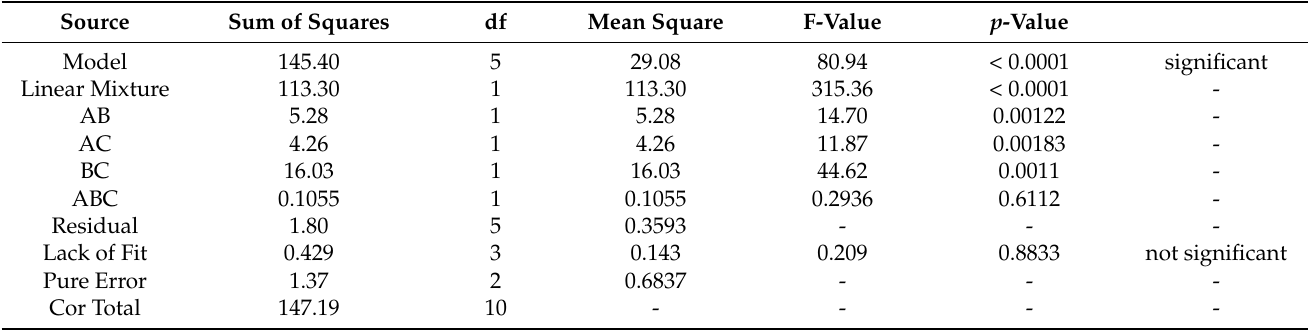
Table 7. ANOVA for crystal size for quadratic and linear